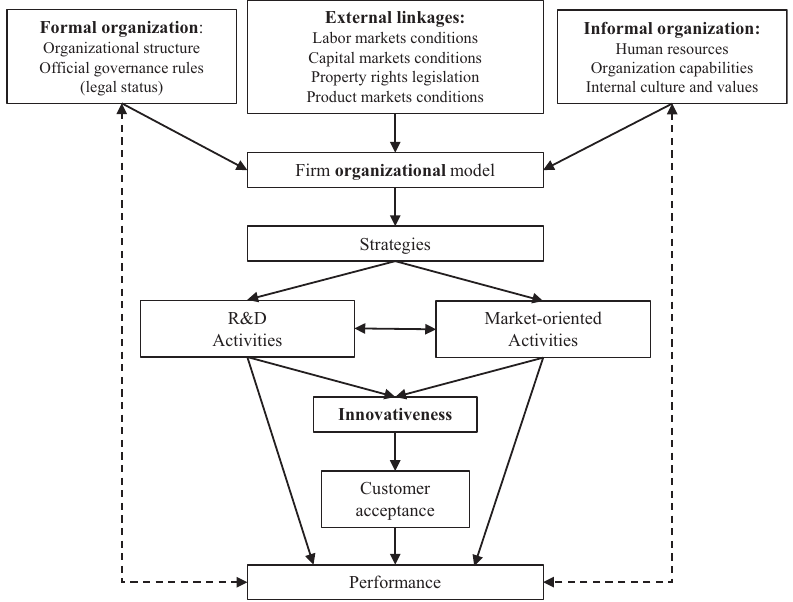
Formal organization : Organizational